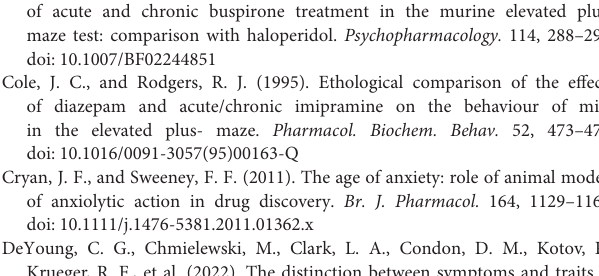
FIGURE 1 | Figure and legend based on (McNaughton et al., 2016; Silva and McNaughton, 2019; McNaughton, 2020) with permission of the author. a, anterior; b, basal; c, central; d, dorsal; ext, external; int, internal; l, lateral; m, medial; p, posterior v, ventral; BNST, bed nucleus of the stria terminalis; SAD, Social Anxiety Disorder; OCD, obsessive compulsive disorder; OFC, orbitofrontal cortex; PAG, periaqueductal gray; θ , these compounds affect the system as a whole by reducing theta rhythmic input.